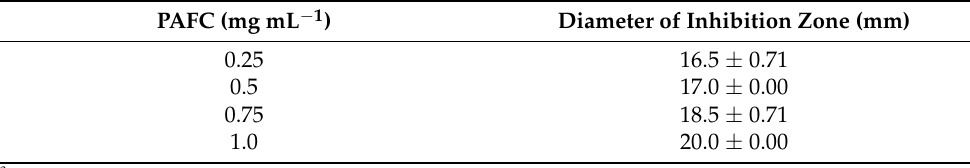
Figure 8. Vegetative growth and root development of Medicago truncatula A-17. ( A ) Morphology of plant seedlings and ( B ) primary root length (gray bars) and number of lateral roots (hatched bars) after daily treatment with 1 mg mL − 1 of PAFC for 10 days at 25 ◦ C under continuous illumination (1200 lux) compared to the ddH 2 O- and 70% ( v / v ) ethanol-treated controls, respectively. Scale bar, 30 mm. Significant difference in ( B ) was evaluated with the two-sample t -test and is indicated with ** ( p < 0.005). Table 5. Inhibition of Botrytis cinerea surface culture growth by PAFC §